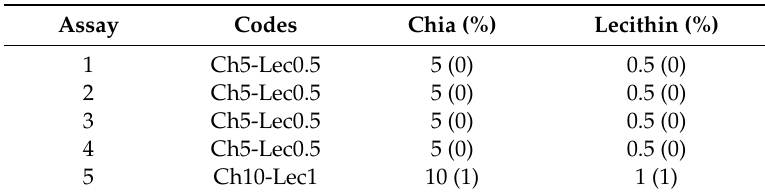
Table 1. Experimental